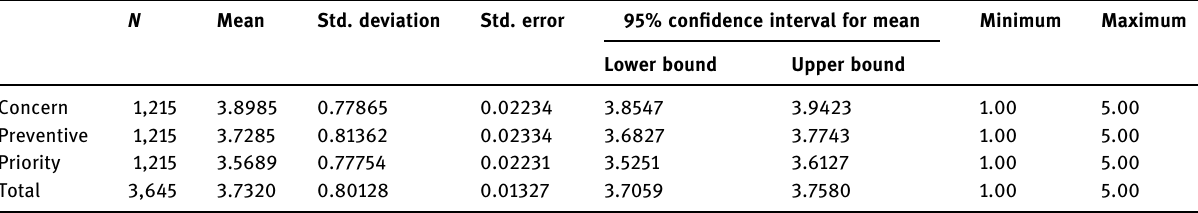
Table 19: Descriptive of awareness level by island N Mean Std. deviation